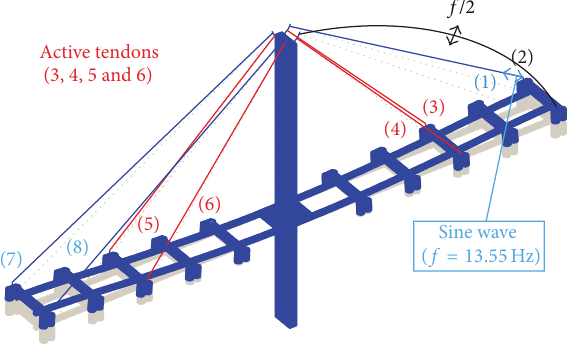
Figure 11: Description of the numerical experience.